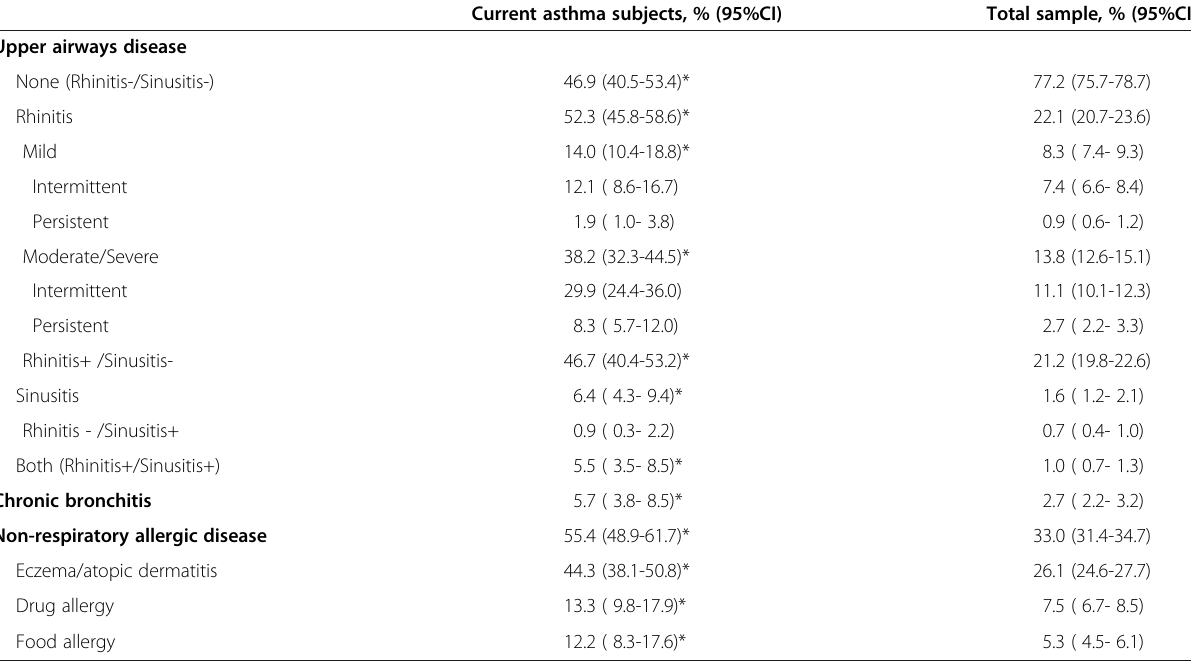
Table 3 Asthma comorbities for ‘ Current asthma ’ subjects (n =450) and for the total sample (n=